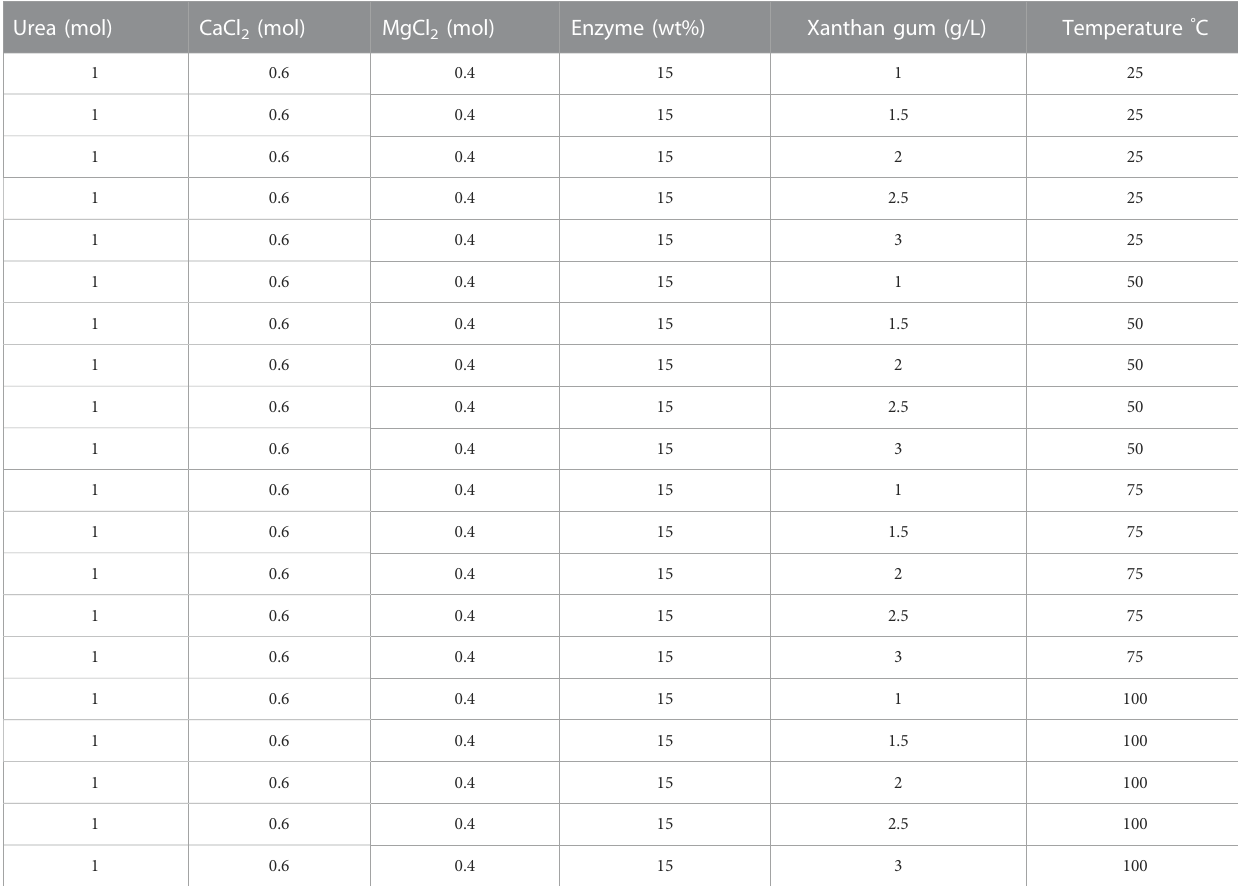
TABLE 4 Chemical formulations used for the effect of Xanthan Gum and temperature sensitivity. Urea